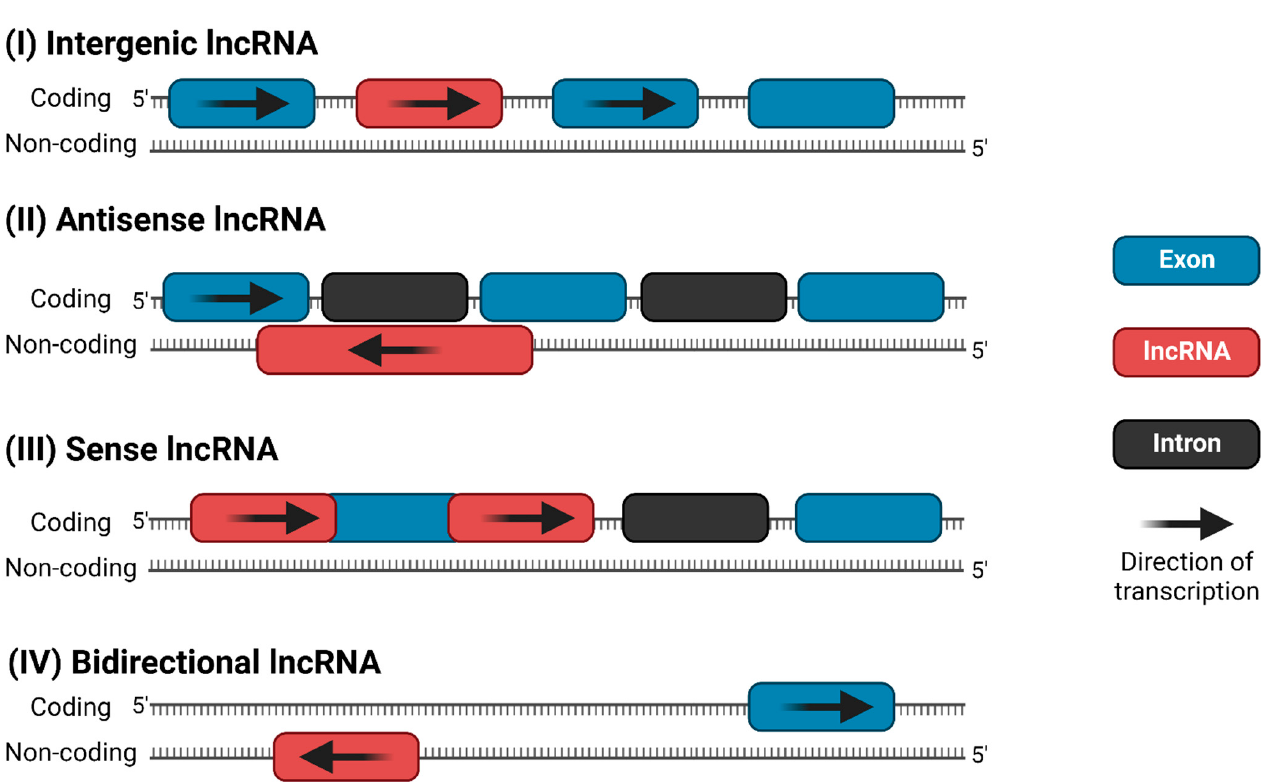
Figure 2. The four most common categories of lncRNAs: ( I ) long intergenic ncRNA (lincRNA), ( II ) antisense lncRNA, ( III ) sense intronic ncRNA, and ( IV ) bidirectional lncRNA.